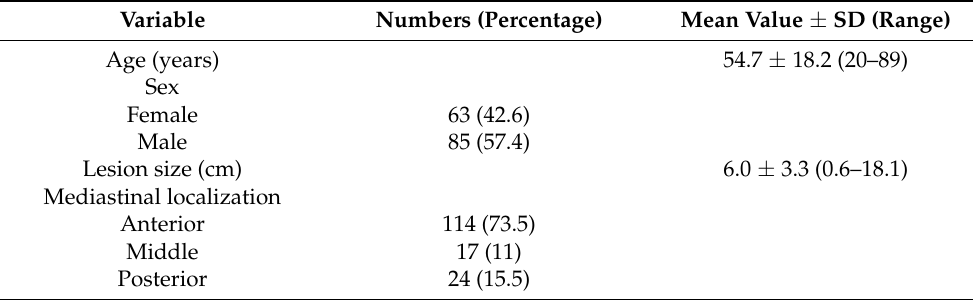
Table 1. Population characteristics in 148 patients having undergone CT-fluoroscopy-guided percuta- neous core needle biopsy of mediastinal